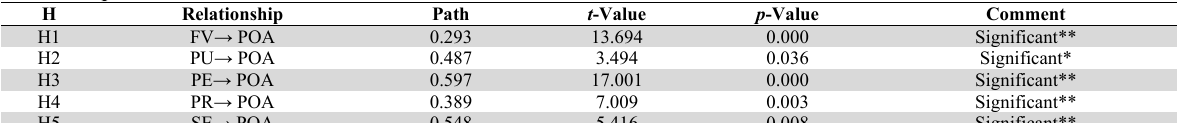
Results of path